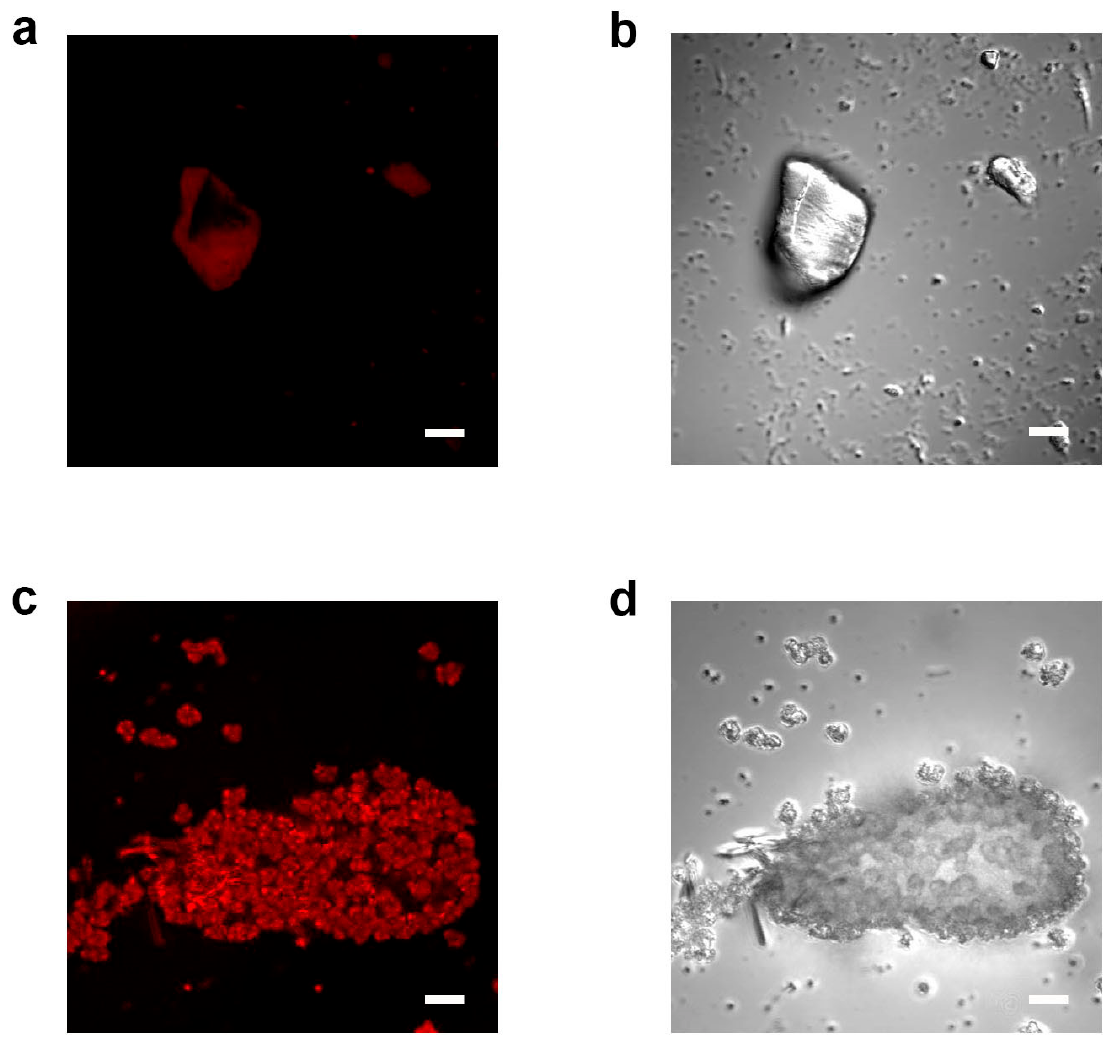
Figure 2. CFM (confocal fluorescence microscopy) and micrograph images: ( a ) fluorescence micrograph of UiO-66; ( b ) micrograph of UiO-66; ( c ) fluorescence micrograph of UiO-66-FA; ( d ) micrograph of UiO-66-FA. Scale bars are 10 µ m, 10 µ m, 5 µ m and 5 µ m, respectively.